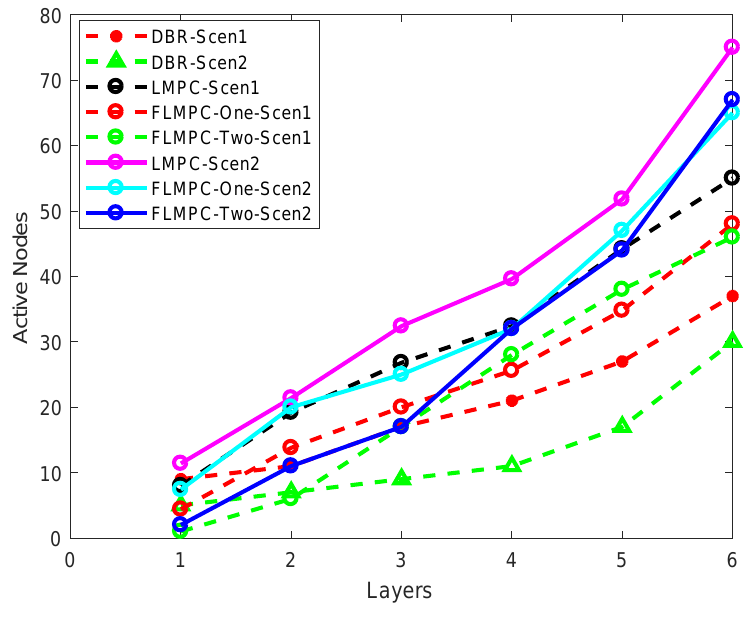
Figure 9. Active